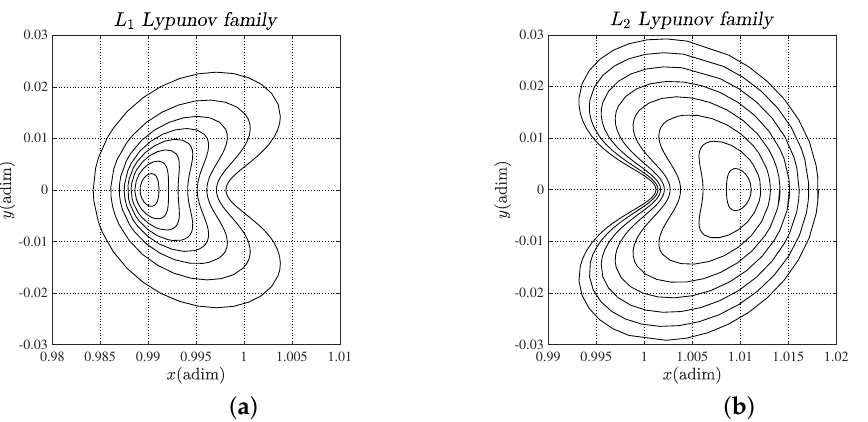
Figure 1. The planar Lyapunov families in the Sun–Earth system: ( a ) the Lyapunov family around L 1 ; ( b ) the Lyapunov family around L 2 .